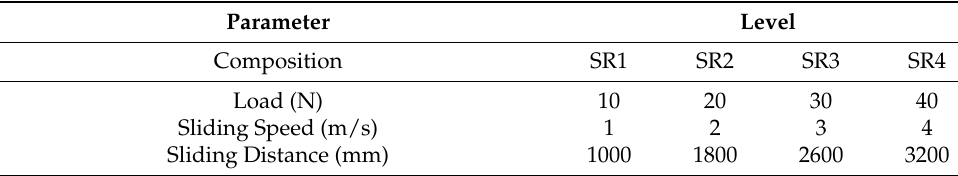
Figure 3. Schematic representation of SR–MMT manufacturing process. Table 3. Selected levels of different